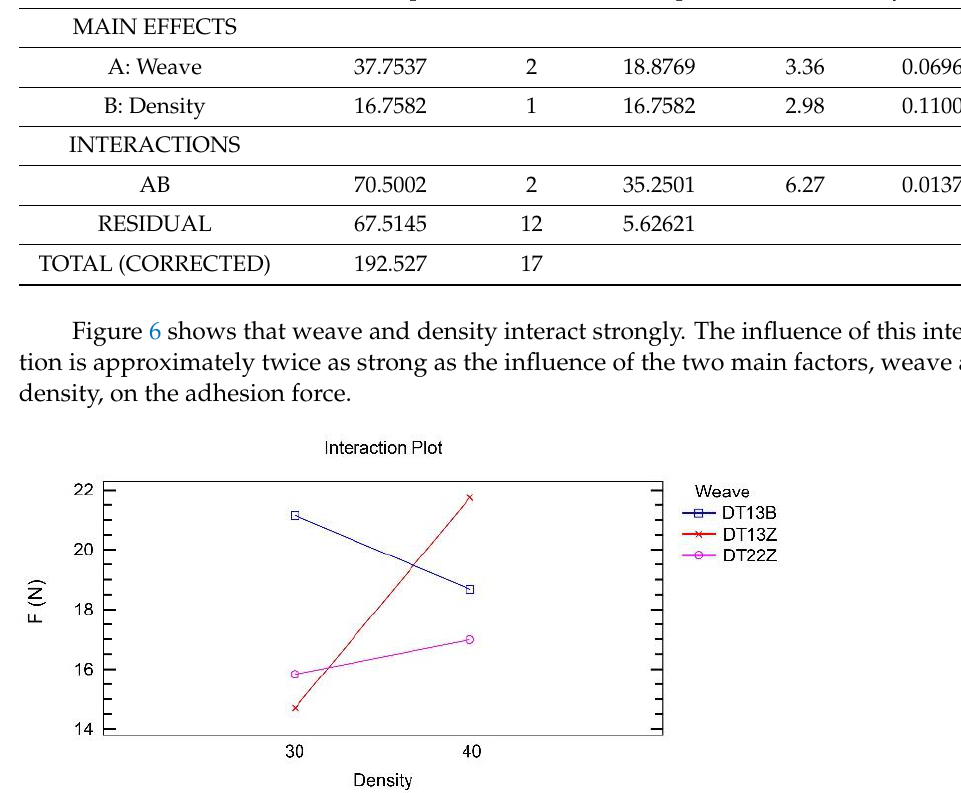
Table 10. Images of fabric samples (mag. 20×) printed at different z-distances (0.25 mm, 0.35 mm, and 0.45 mm).